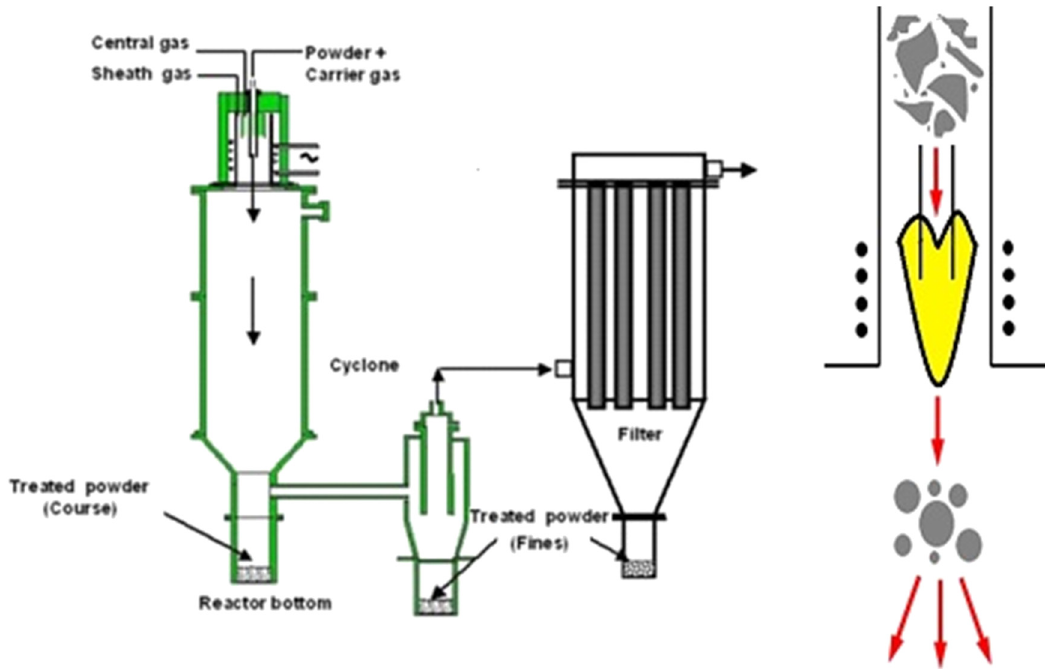
Figure 1: Schematic representation of the TEKNA Tek - 15 system and spheroidization